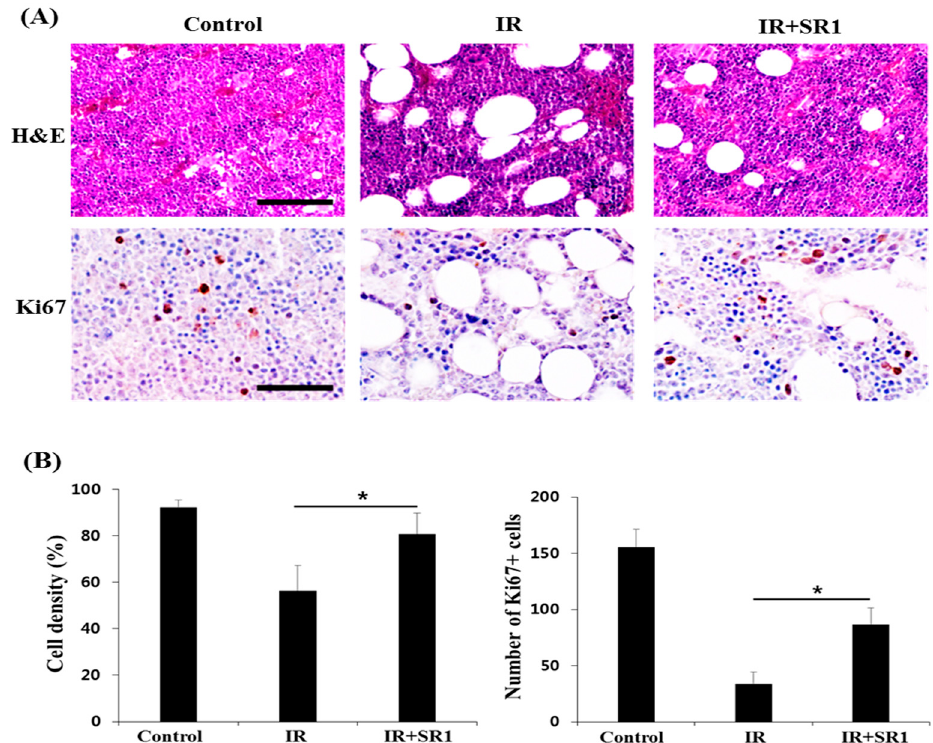
Figure 2. Mitigating effect of SR1 with respect to TBI-induced bone marrow (BM) depletion in vivo. Representative images ( A ) and quantification ( B ) of the effect of SR1 on BM depletion in mice (n = 3 and 8) at 30 days after irradiation. Panels show Hematoxylin and Eosin staining (BM cellularity) and Ki-67 staining (BM cell proliferation) of mouse femurs. Scale bars, 100 µm. * p < 0.05 versus IR and IR+SR1 group.